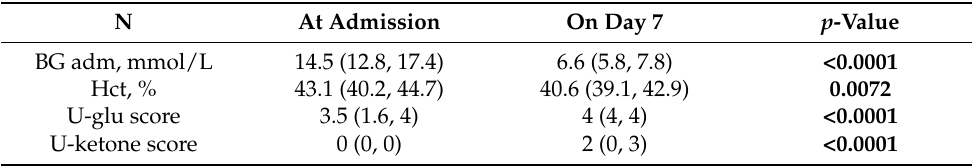
Table 4. Changes in Hct level, glucose level, and urine test (N =